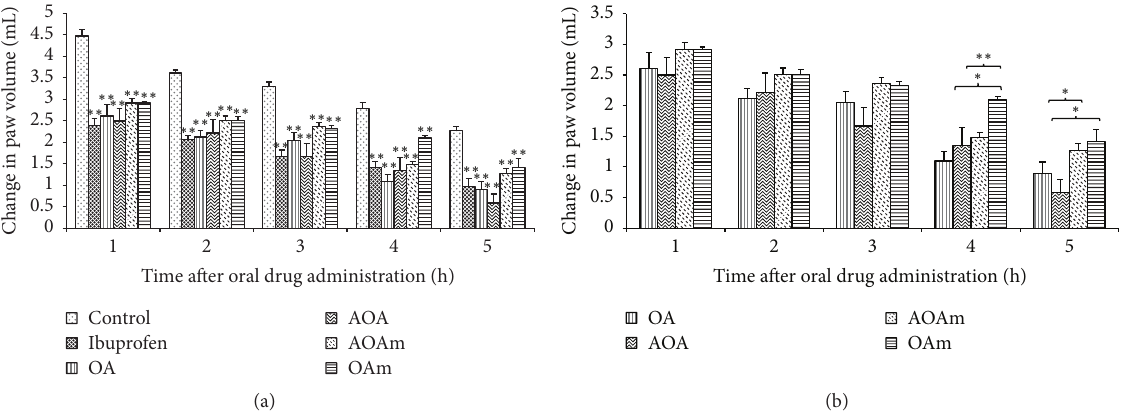
Figure 6: Anti-inflammatory effect of OA (oleanolic acid), AOA (3-acetyloleanolic acid), AOAm (28-methyl, 3-acetyloleanane), and OAm (28-methyloleanane). Results are presented as mean change in paw volume ± SEM for 6 animals; ∗ 𝑝 < 0.05 and ∗∗ 𝑝 < 0.01 . (a) shows a comparison of the tested compounds with control group, whereas (b) shows the comparison of anti-inflammatory effects of the oleanane compounds with